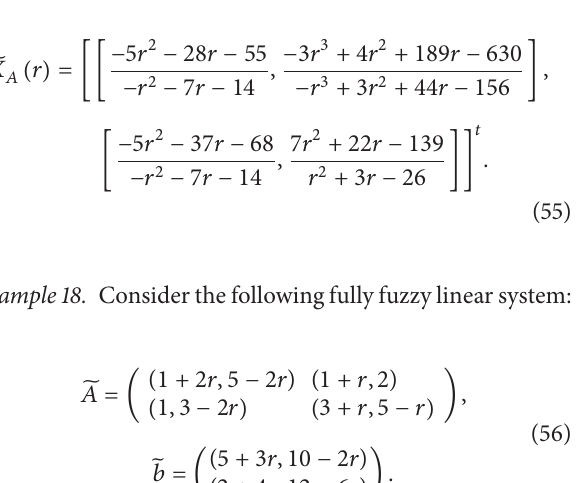
Figure 1: Compare and ̃𝑥 +,𝑙,𝑢 𝐺 ( ◻ ).